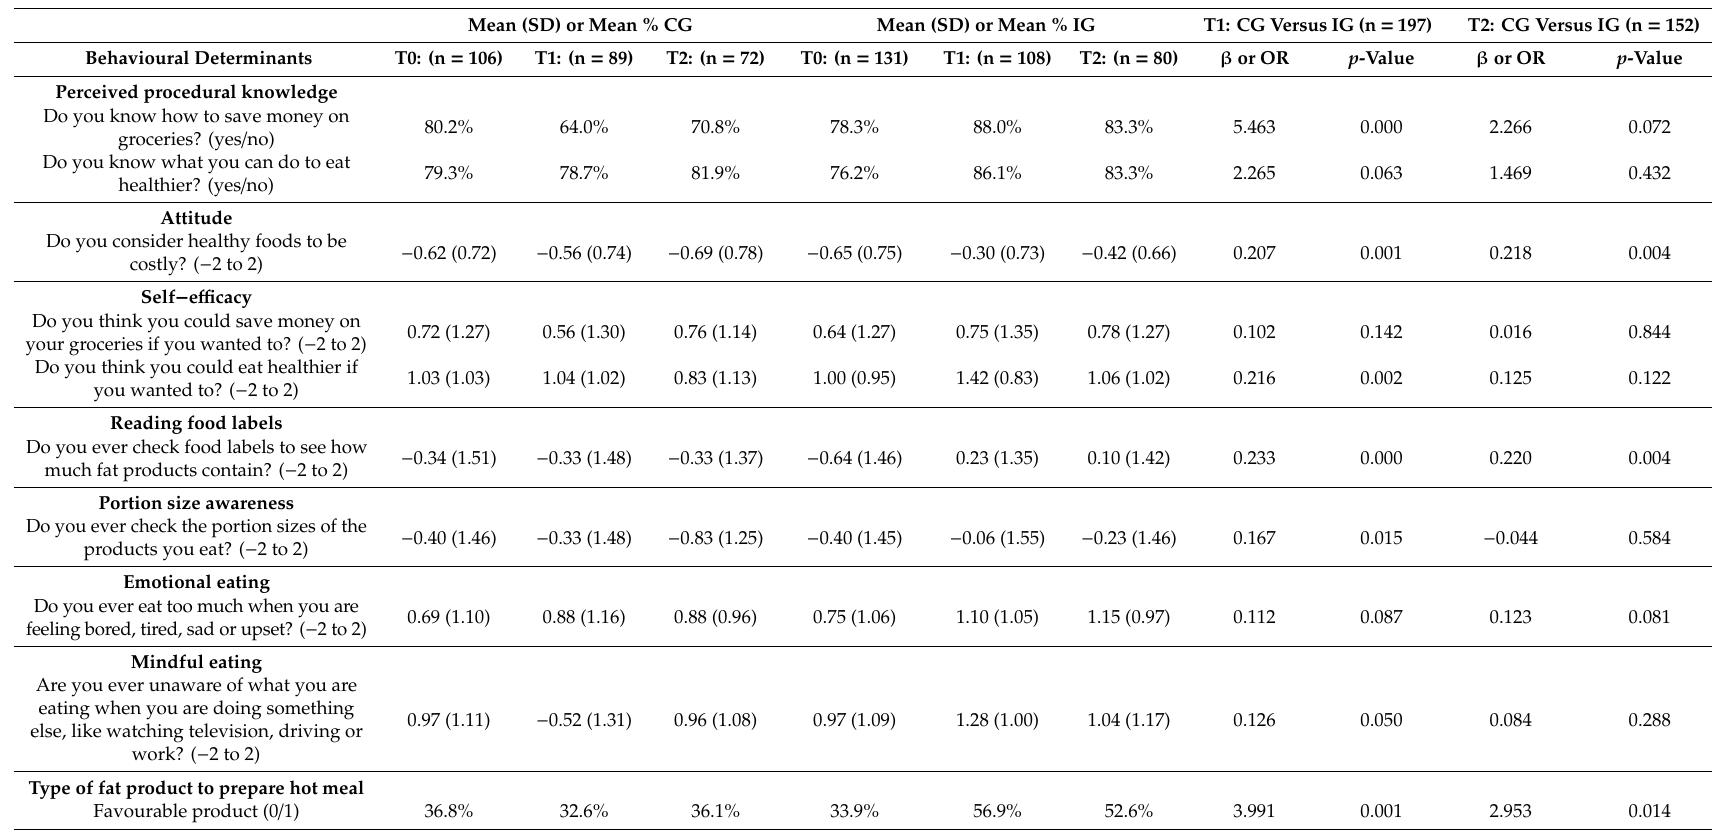
Table 3. Behavioural determinants and use of liquid butter or oil in the control group and intervention group at post-test (T1) and follow-up (T2): observed descriptive statistics and e ff